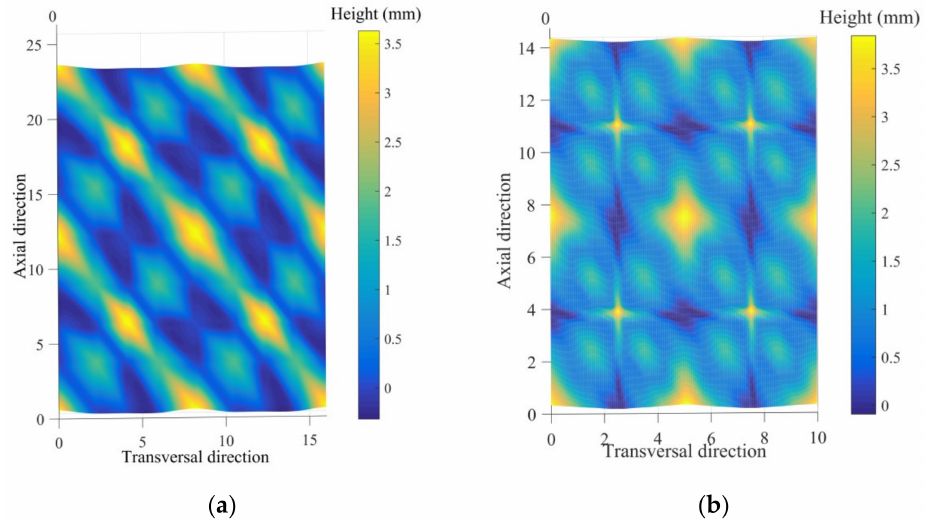
Figure 16. Thermal impregnation distribution of 2D biaxial braided prepregs unit cell: ( a ) BR-A and ( b )